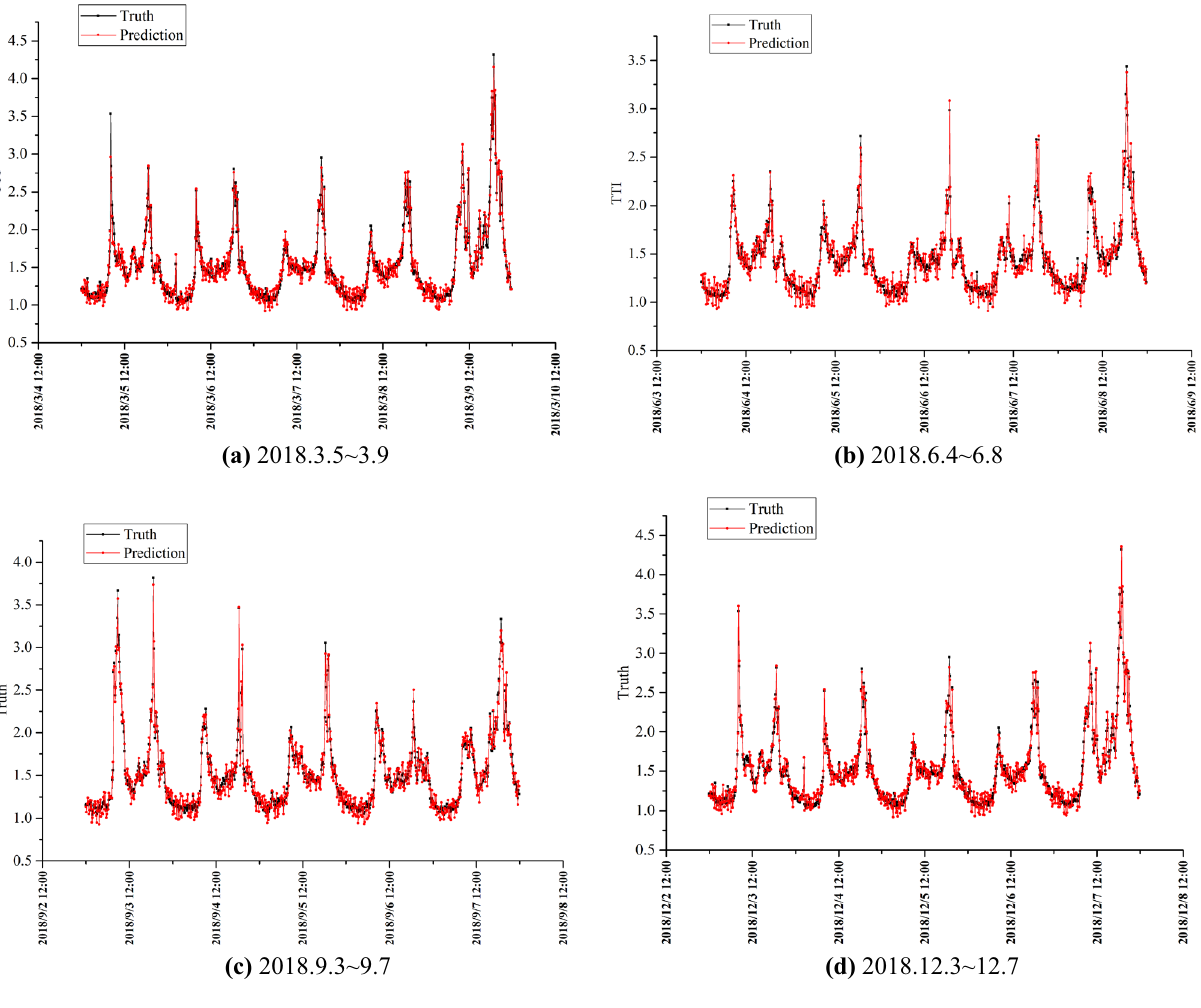
Figure 5. The model predicts results over four working